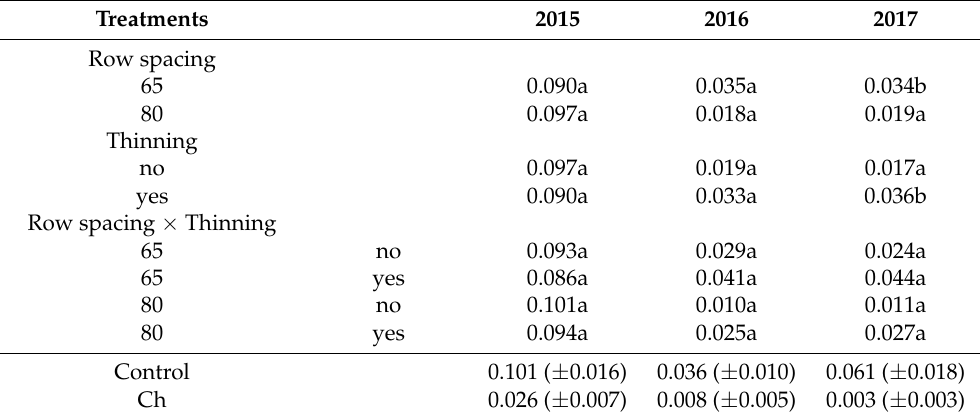
Table 2. Mean numbers of Syrphidae larvae per one broad beans plant in the 2015–2017 seasons.